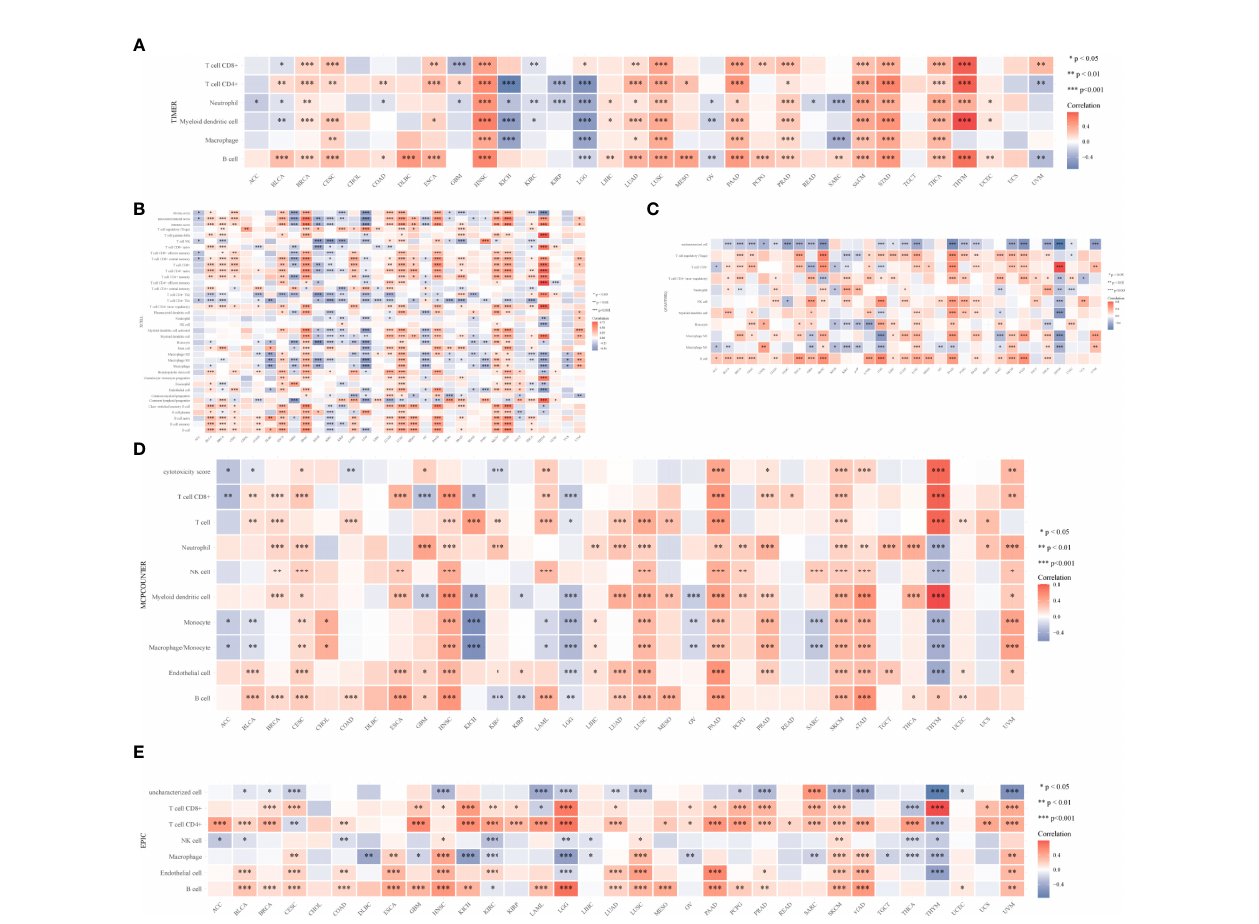
FIGURE 12 | CYFIP2 ’ s role in tumor immune response. (A) EPIC_Immu_score. (B) XCELL_Immu_score. (C) QUANTISEQ_Immu_score. (D) MCPCOUNTER_Immu_score. (E) TIMER_Immu_score. *p < 0.05, **p < 0.01, ***p <